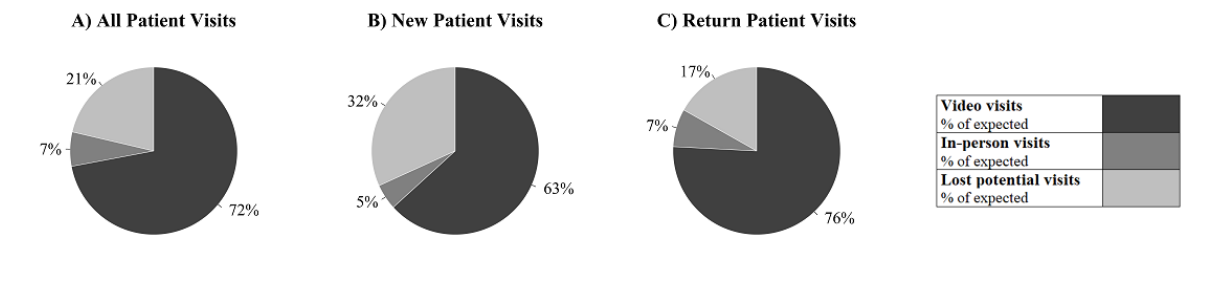
Figure 1. Percentage of video visits conducted between March 22 and May 16, 2020, as a proportion of (A) all "expected" visits overall, (B) "expected" new patient visits, and (C) "expected" return patient visits. The "expected" number of visits is defined as the number of completed visits in the comparable 2019 time period. Data only reflect operational scheduling data captured through the EPIC Hyperspace Platform. The data do not reflect no shows, visits conducted on other HIPAA-compliant software or visits that reverted to phone calls. (HIPAA: Health Insurance Portability and Accountability